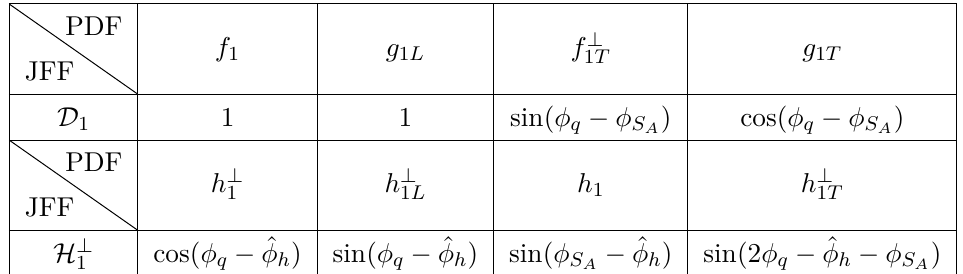
Table 4 . Summary of the characteristic azimuthal asymmetry with which different TMDPDFs and TMDJFFs arise for back-to-back electron-jet production, with unpolarized hadrons observed inside the jet. See eqs. (3.3) and (C.5)–(C.12) for parametrizations of structure